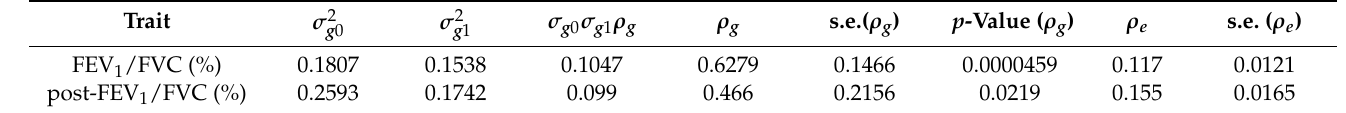
Figure 2. Single nucleotide polymorphism (SNP) heritability of eight lung function traits. SNP heritability of subject-specific means ( a ) and the annual change rates ( b ) in eight lung function traits. Error bars correspond to standard error. The black dots on the bars represent p -values. The black dashed line indicates the 0.05 significance level. Red dots indicate significant findings at a false- discovery rate of 0.05. FVC, forced vital capacity; FEV 1 , forced expiratory volume in 1 s; FEV 1 /FVC, forced expiratory volume in 1 s to forced vital capacity ratio; FEF 25–75%, the average forced expiratory flow during the mid (25–75%) portion of the FVC; MVV, maximal voluntary ventilation; post-FVC, post-bronchodilator test for FVC; post- FEV 1 , post-bronchodilator test for FEV 1 ; post- FEV 1 /FVC, post-bronchodilator test for FEV 1 / FVC ratio. Table 2. Genetic correlation of subject-specific means ( ˆ β 0 ) and annual change rates ( ˆ β 1 ) in lung function traits with significant p -values ( p <